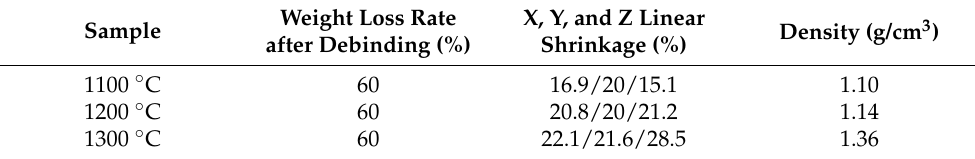
Table 2. Physical properties of the ceramic sample according to the sintering temperature.